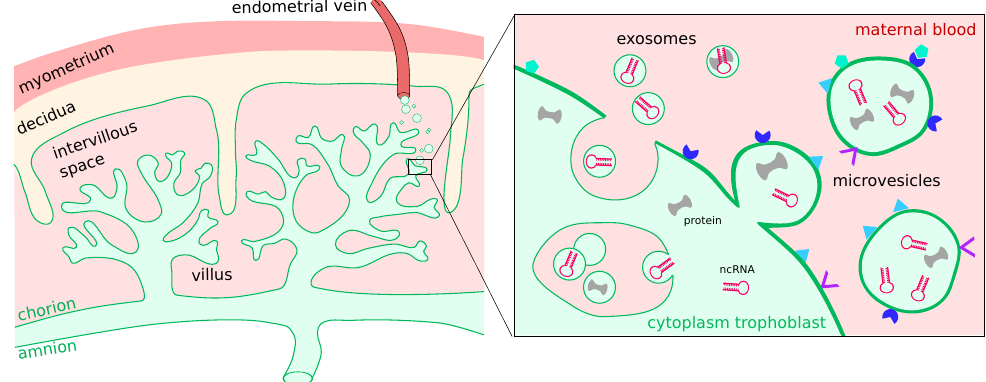
Figure 3. Extracellular vesicles are released from the syncytiotrophoblast cells into the maternal blood. Microvesicles and exosomes can contain proteins, metabolites and non-coding